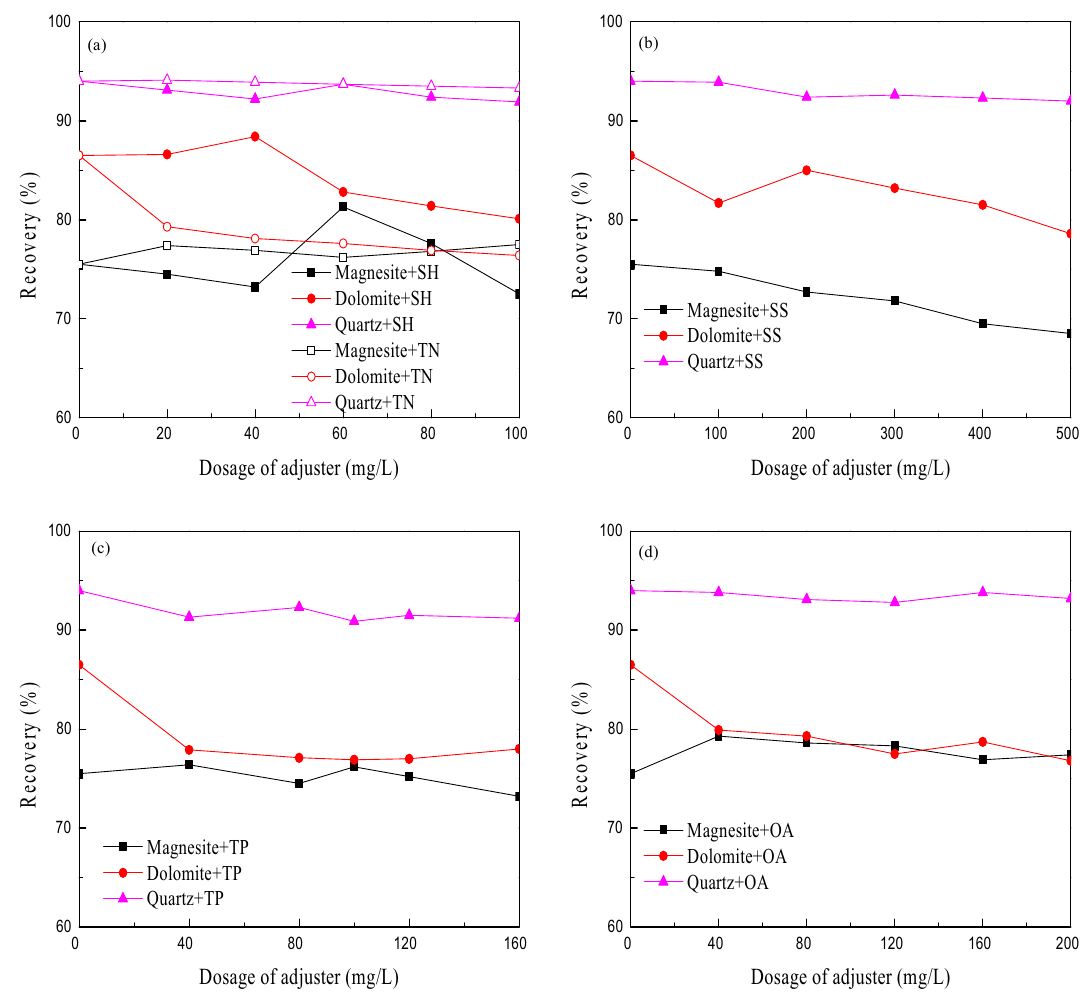
Figure 4. The effect on floatability of the regulators SH and TN ( a ), SS ( b ), TP ( c ), and OA ( d